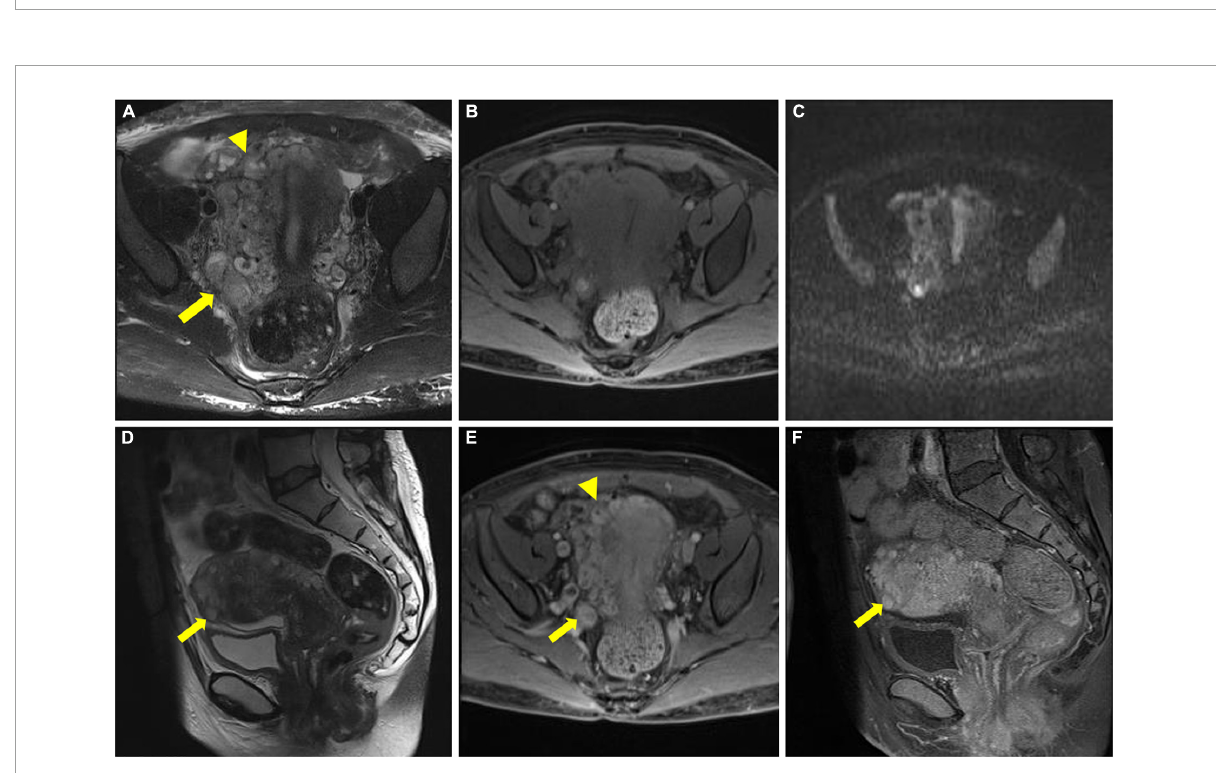
FIGURE3 Pelvic magnetic resonance imaging (MRI) image. (A–C) Multiple tortuous and dilated vascular structures at the fundus of the uterus (arrowhead) and the parametrium (arrow). (D) Multiple nodules of varying sizes were observed at the fundus of the uterus (arrow). (E,F) After gadolinium-based contrast material injection, progressively enhanced lesions were noted within the lumen (arrowhead and arrow in E ), and the nodules also presented progressive enhancement (arrow in F